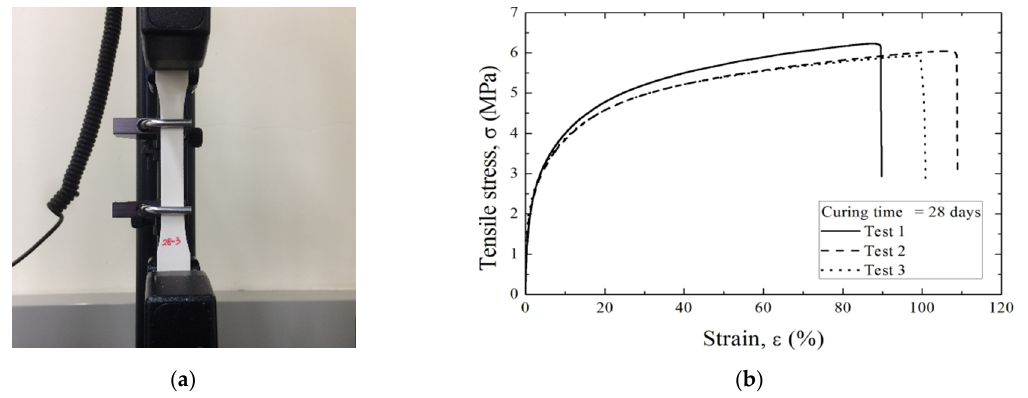
Figure 1. Tensile testing: ( a ) setup and ( b ) results of three tests for samples cured for 28 days.